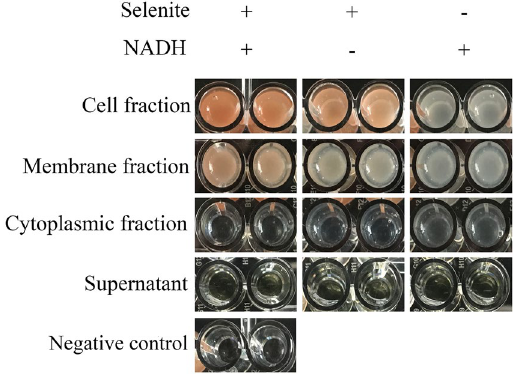
Figure 3. Selenite-reducing ability of different fractions of E. cloacae Z0206. The selenite-reducing ability of the bacterium was estimated using the following reaction mixture: 100 µ g protein, 10 mM selenite and 10 mM